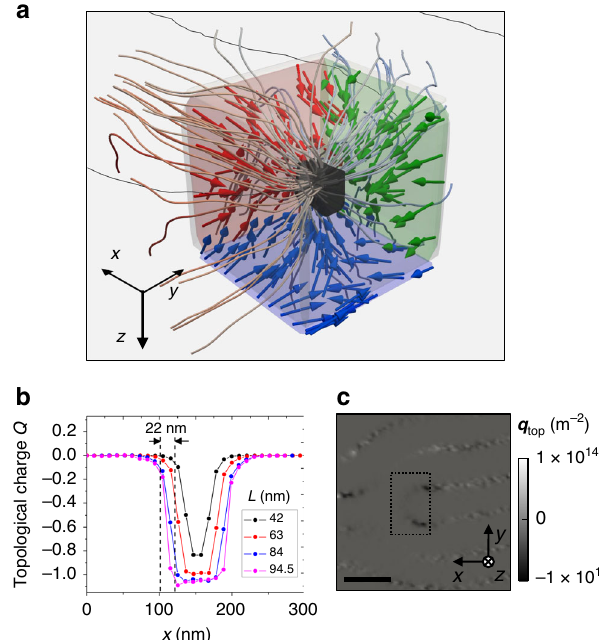
Fig. 4 Experimental determination of topological charges. a Streamlines and arrows of emergent magnetic fi eld around the Bloch point in bifurcation D1 enclosed by a cube of 100 nm lateral size. b x Pro fi le of the total topological charge Q obtained integrating over cubes of different side dimensions indicated in the inset. The precision on the localization of the Bloch point is ca. 22 nm (see main text). c Density of topological charge q top in the x , y plane ( q z ) at the central part of the sample near D2 of Fig. 3c. The dashed rectangle shows the integration area. Scale bar 250